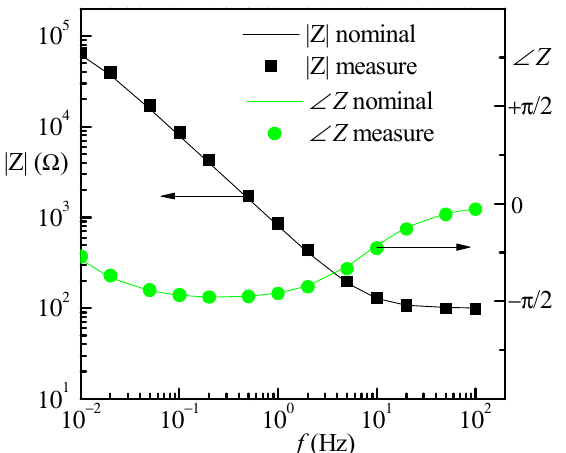
Figure 8. Result of test measurements on the impedance in Figure 6a. DC bias across the DUT was set to 0 and the AC amplitude of the test voltage was 10 mV at all frequencies. Quite good agreement is obtained between measurements (symbols) and the expected values (solid lines).